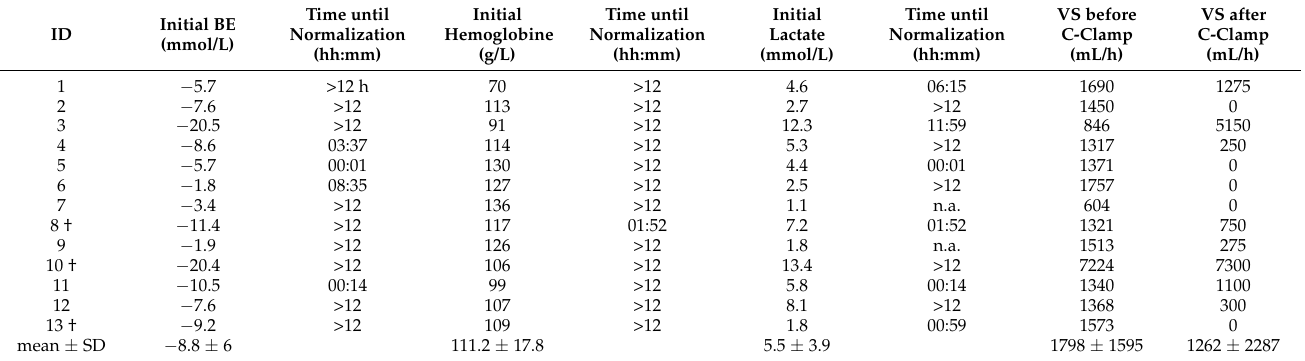
Table 3. Secondary outcome parameters before and after C-clamp application in patients with un- stable pelvic ring fractures and hemodynamic instability.